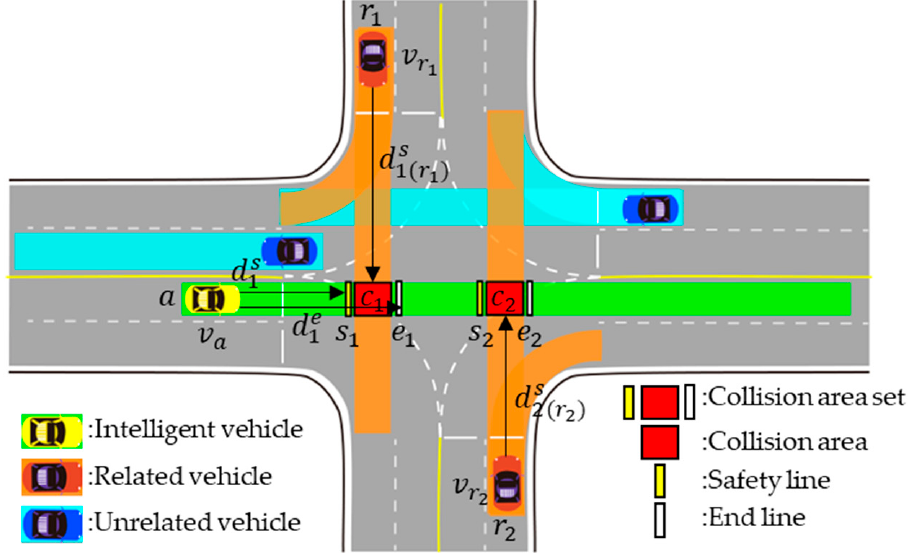
Figure 4. Potential threat identi fi cation.